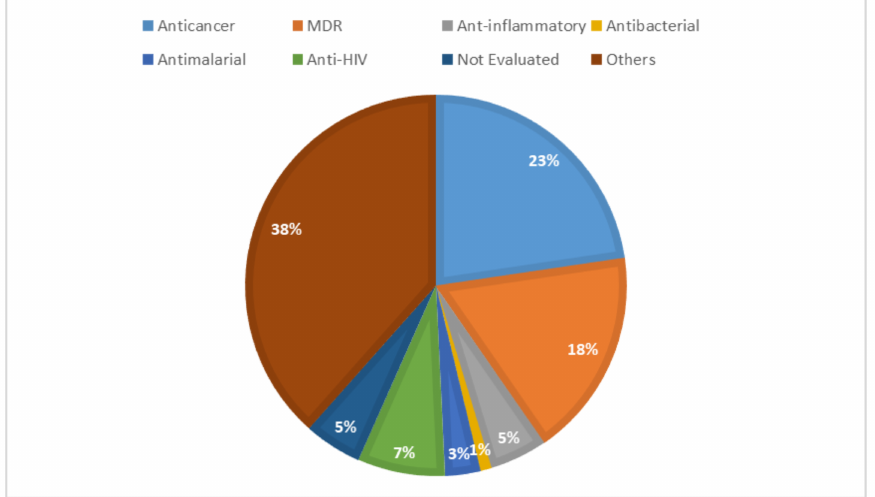
Figure 16. Distribution of publications describing different biological